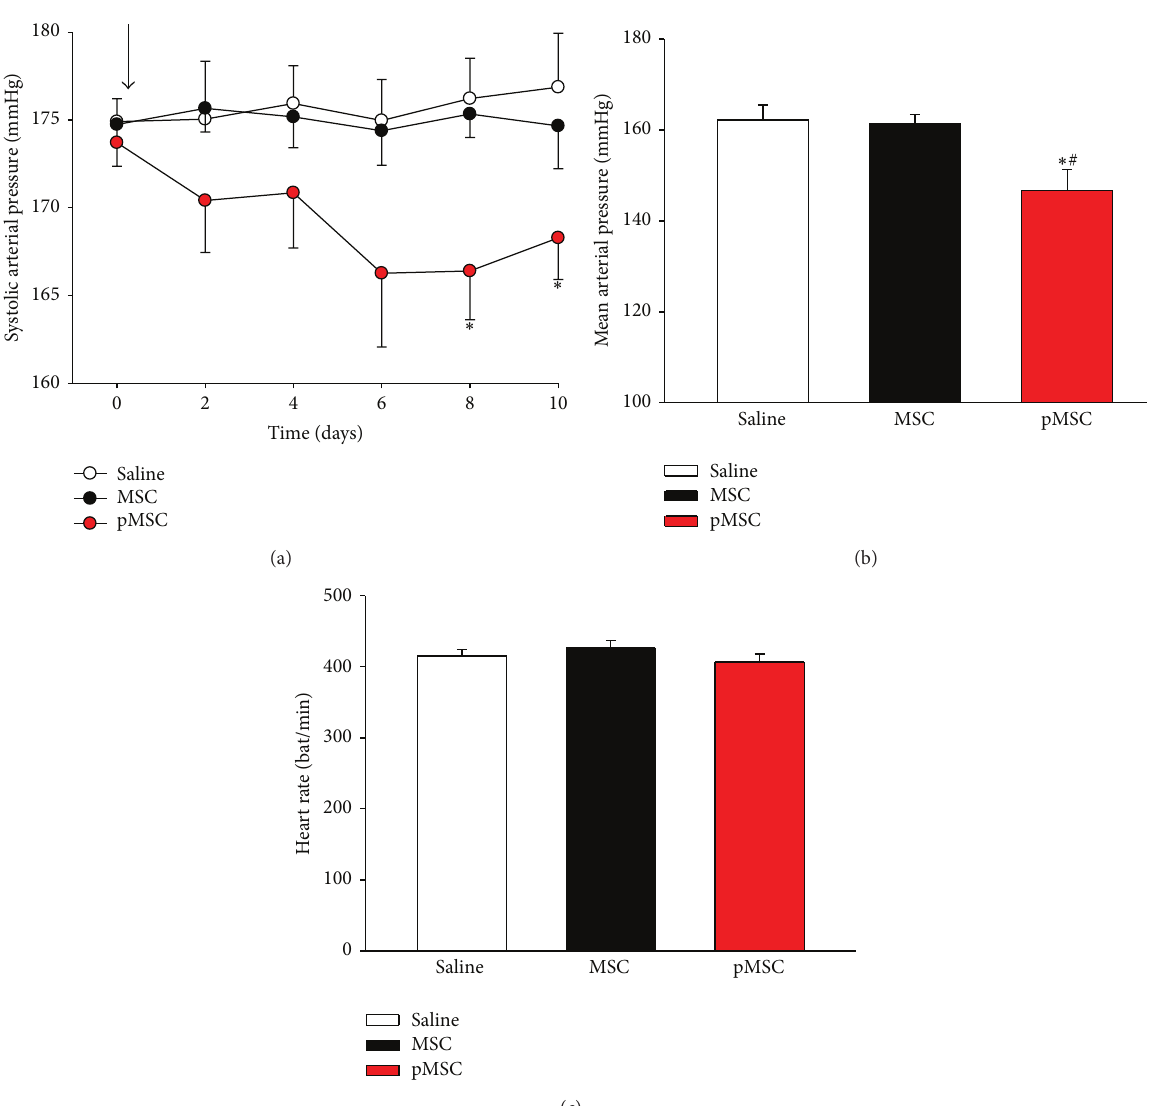
Figure 3: (a) Time course of systolic arterial pressure (SBP). Indirect measurement of systolic blood pressure from day 0 until day 10 after treatment. Arrow indicates the time of transplantation. (b) Values of mean arterial pressure obtained at the end of the observation period through direct measurement of arterial blood pressure. (c) Values of heart rate of three experimental groups measured at the end of the observation period. Values indicated as the mean ± sem. ∗ 𝑝 < 0.05 versus saline; # 𝑝 < 0.05 versus